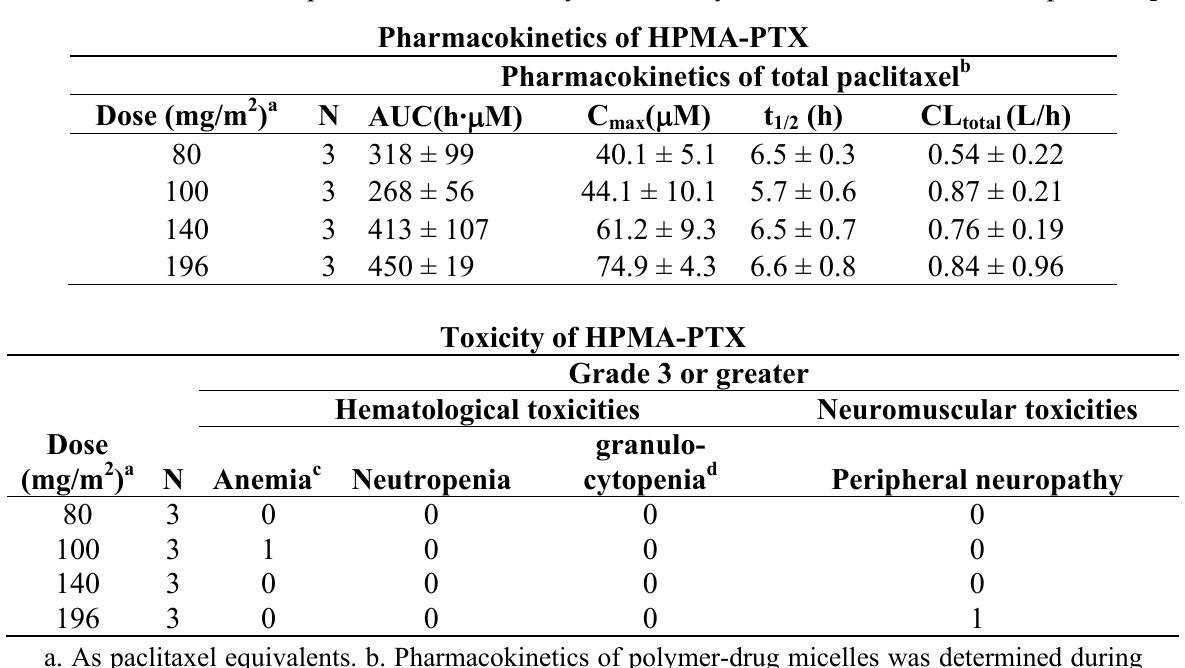
Table 6. Results of Phase I pharmacokinetic study and toxicity of HPMA-PTX in cancer patients